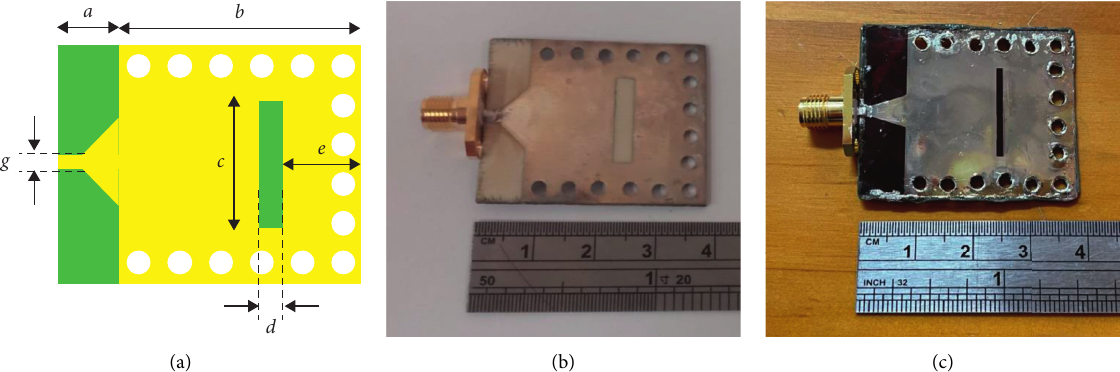
Figure 9: (a) The geometry of the fully inkjet-printed SIW antenna and the photographs of the SIW antenna fabricated on (b) RO4003C and (c) PI.